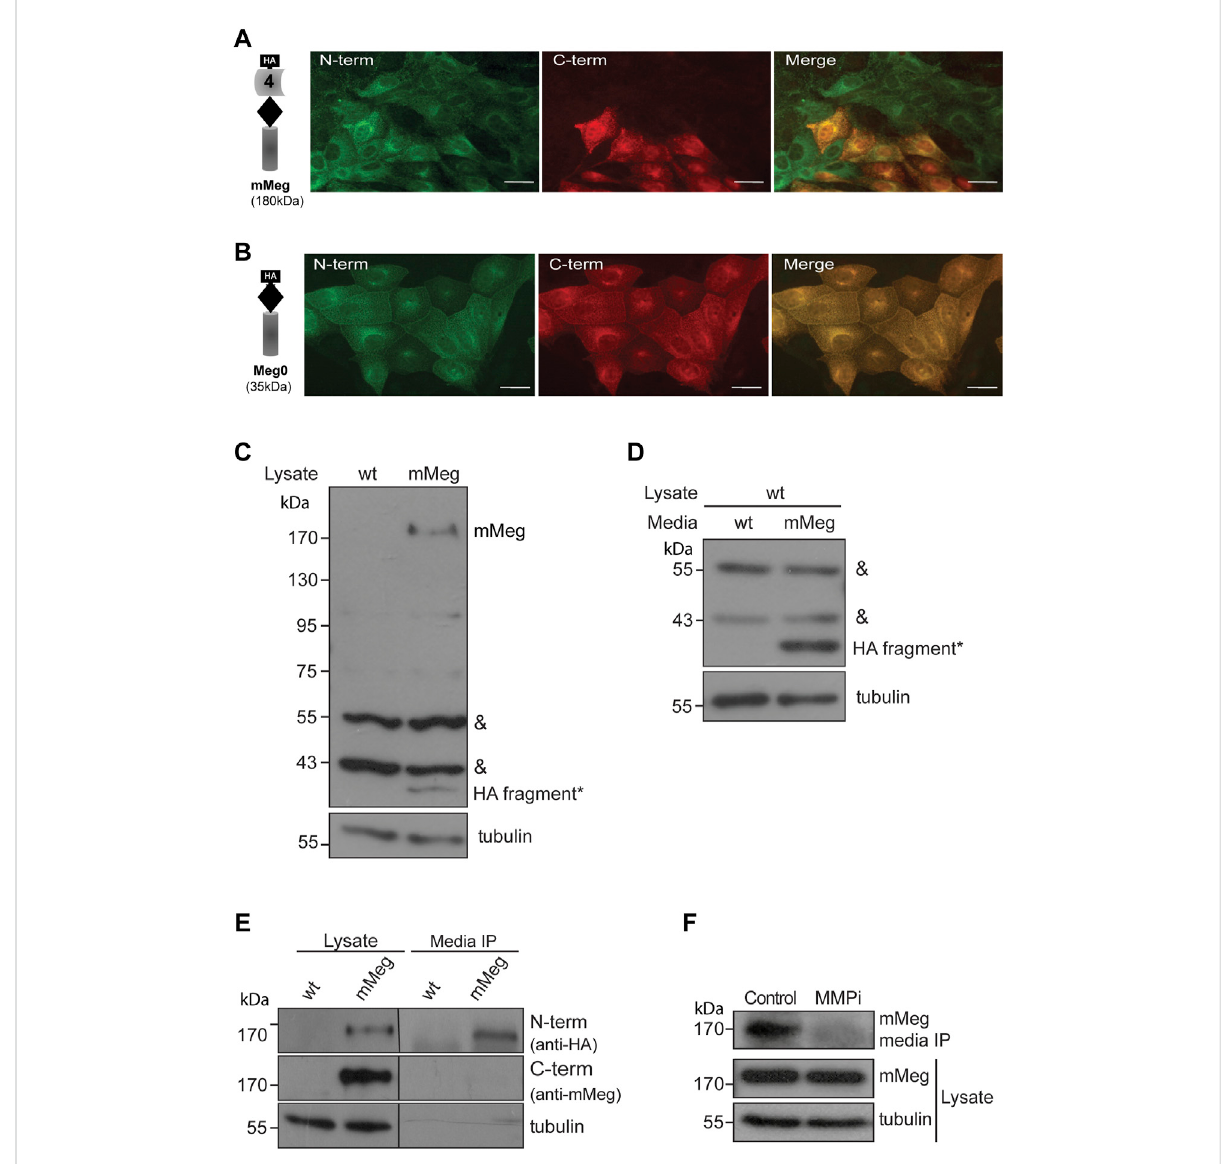
FIGURE 2 Characterization of megalin intracellular and secreted fragments. Immuno fl uorescence of LLC-PK1 cells stably expressing (A) mMeg or (B) Meg0 to detect amino-terminal (N-term) or carboxy-terminal (C-term) domains of the receptor with anti-HA (green) and anti-Megalin (red) antibodies, respectively. The images were acquired by epi fl uorescence microscopy. Scale bar, 10 µm. (C) Whole-cell lysates of wt LLC-PK1 and mMeg-LLC-PK1 cells were analyzed by western blot using anti-HA to detect mMeg or its N-term fragments. Symbols correspond to a non- speci fi cband(&)andthelowmolecularweightbandexclusive tothemMegexpressingcelllysate(*). (D) Whole-celllysatesofwtLLC-PK1cellswere incubated with conditioned media of either wt or mMeg -LLC-PK1 cells, analyzed by western blot using an anti-HA antibody, which recognizes the N-terminalportionofmMeg.Symbolscorrespondtothenon-speci fi cband(&)andlowmolecularweightbandfoundinthecelllysateofwtLLC-PK1 cells incubated with conditioned media from mMeg-expressing LLC-PK1 cells (*). (E) mMeg-LLC-PK1 cells were grown to con fl uence for 48 h. The conditioned medium was concentrated and then immunoprecipitated with an anti-HA antibody. Protein samples, immunoprecipitated media, and celllysateswereanalyzedwithananti-HAantibodytodetectmegalinectodomain(N-term)andwithananti-megalincytoplasmicdomainpolyclonal antibody to detect megalin carboxy-terminal fragment (C-term). Tubulin was used as a loading control. (F) mMeg expressing cells were incubated with vehicle (Control) or 10 μ M MMPi (GM6001, general matrix metalloprotease inhibitor) for 48 h and replenished every 12 h. The immunoprecipitated media and cell lysates were analyzed by western blot to detect mMeg and tubulin as load